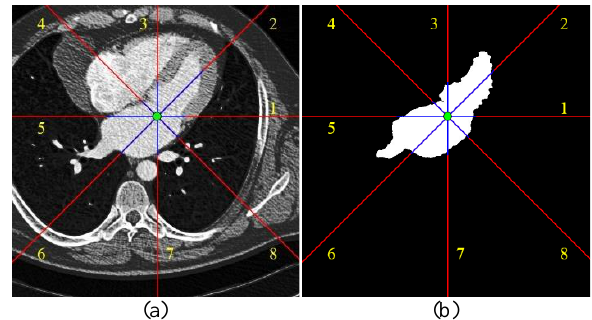
Figure 3. Visual representation of ray emission: pre-processed source image (a) and manually labeled mask (b)